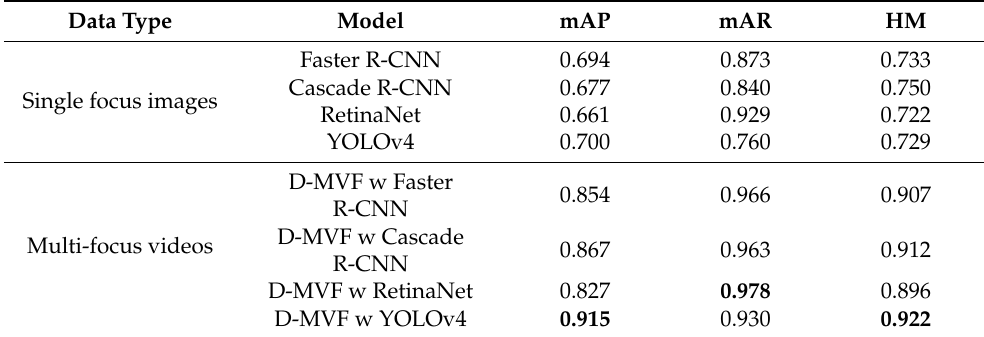
Table 3. Comparison of mAP, mAR, and HM between different U-RBC detection methods based on single-focus image and multi-focus videos. The bolded numbers are the best